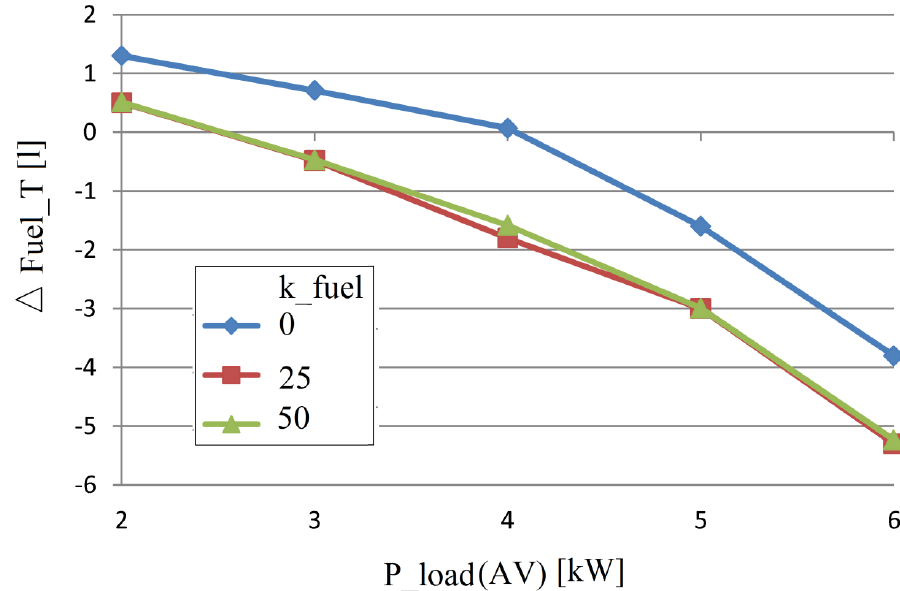
Figure 12. Fuel economy for the RTO1 strategy in case A ( k fuel = 0), B ( k fuel = 25), and C ( k fuel = 25) under variable load.